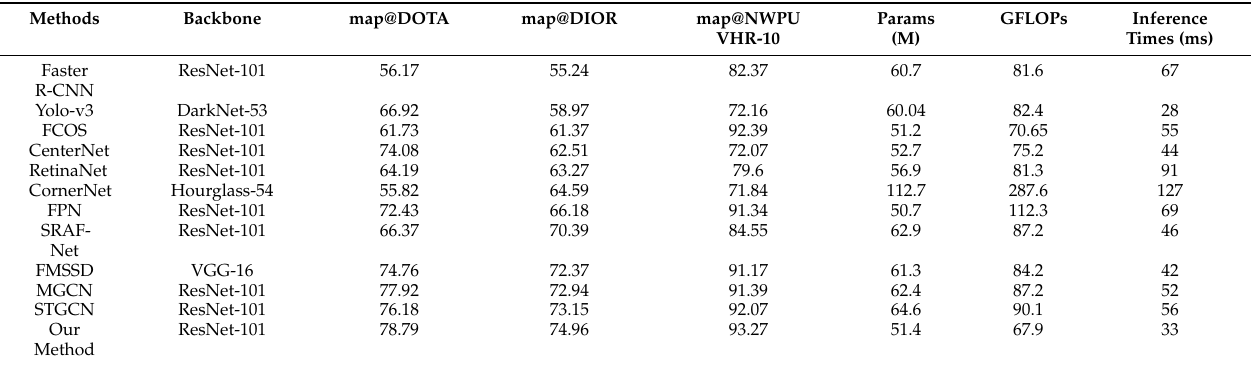
Table 5. Computational cost comparison and analysis of different